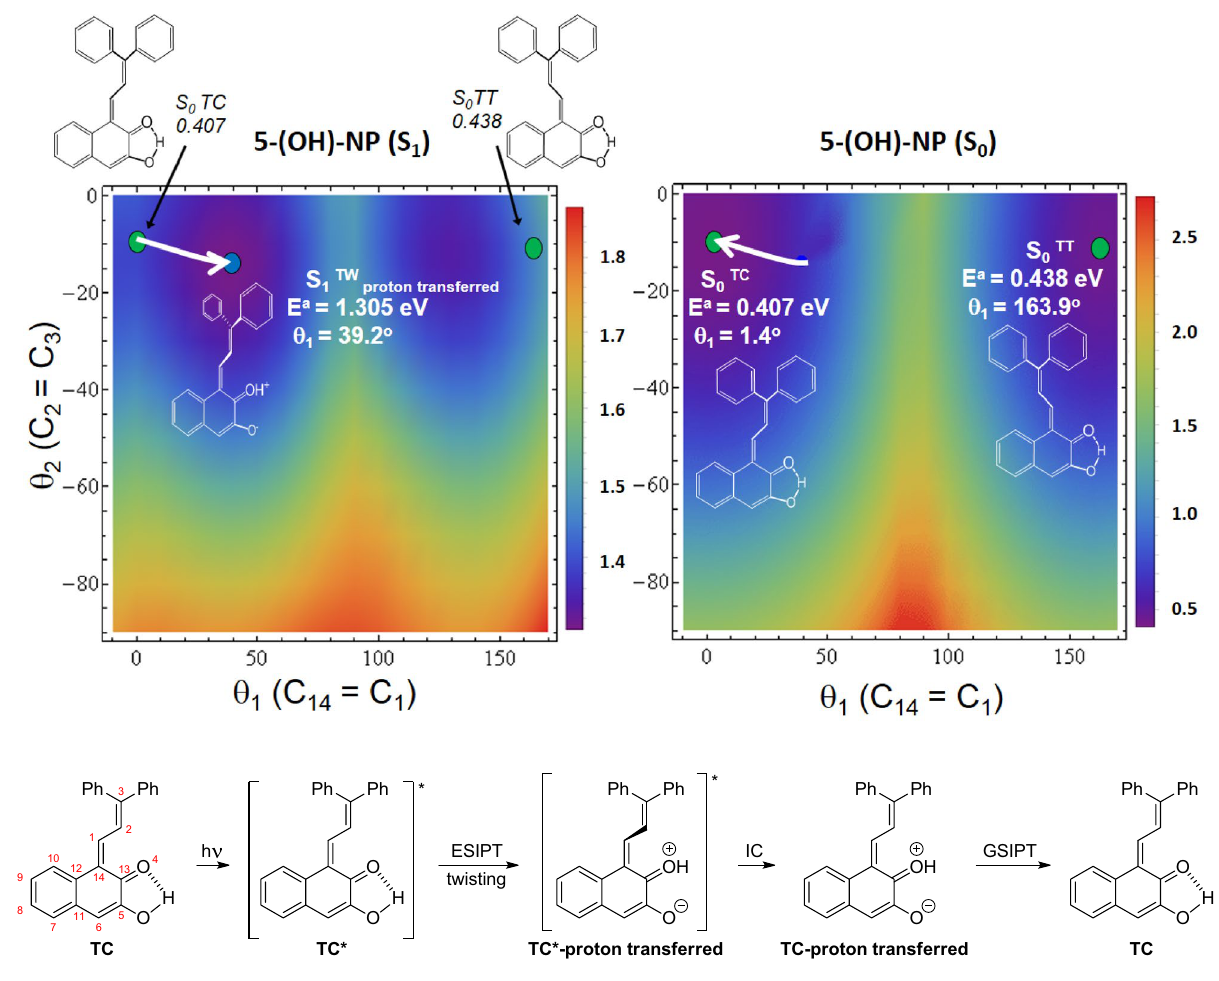
Figure 4. Minimum potential-energy surface of the lowest excited (left) and the ground electronic state (right) of the 5-(OH)-TC (H-bonded) species mimicking system evolution, plotted as a function of θ 1 (C 14 =C 1 ) and θ 2 (C 2 =C 3 ) torsional angle coordinates. Green circles represent the Franck–Condon regions of the ground-state S 0 TC and S 0 TT local minima. Blue circle represents S 1 TC minimum populated after S 0 TC photoexcitation. White arrows show the evolution of the system. The results were obtained with the aid of the ADC(2)/cc-pVDZ method, for the excited state (S 1 ), and with the MP2/cc-pVDZ, for the ground state (S 0 ). The reaction scheme below shows steps in the photocycle free from TT